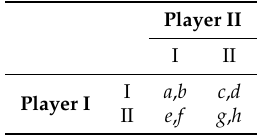
Table 15. An example where the follower does not benefit from incentive